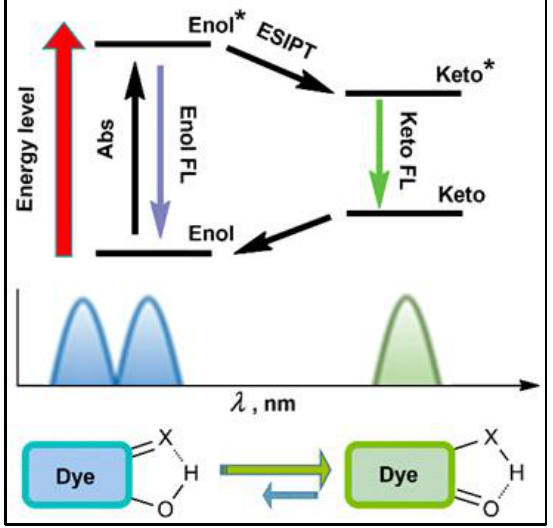
Figure 31. ESIPT photophysics.